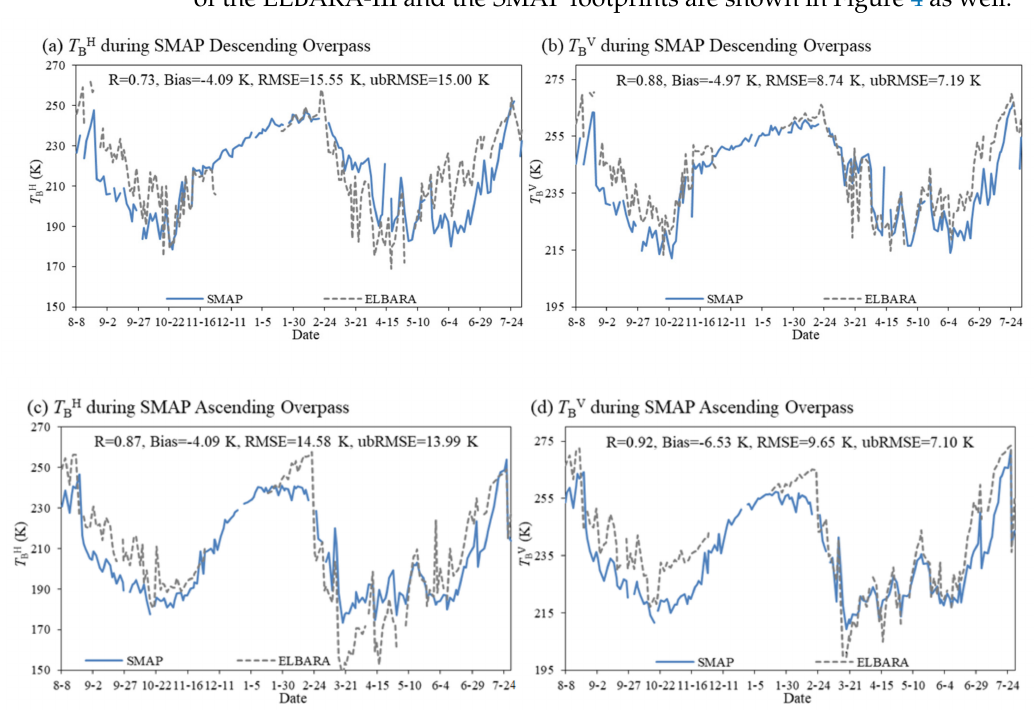
Figure 3. Time series of SMAP and ELBARA-III measured ( a , c ) T B H and ( b , d ) T B V during the SMAP ( a , b ) descending and ( c , d ) ascending overpasses between August 2016 and July